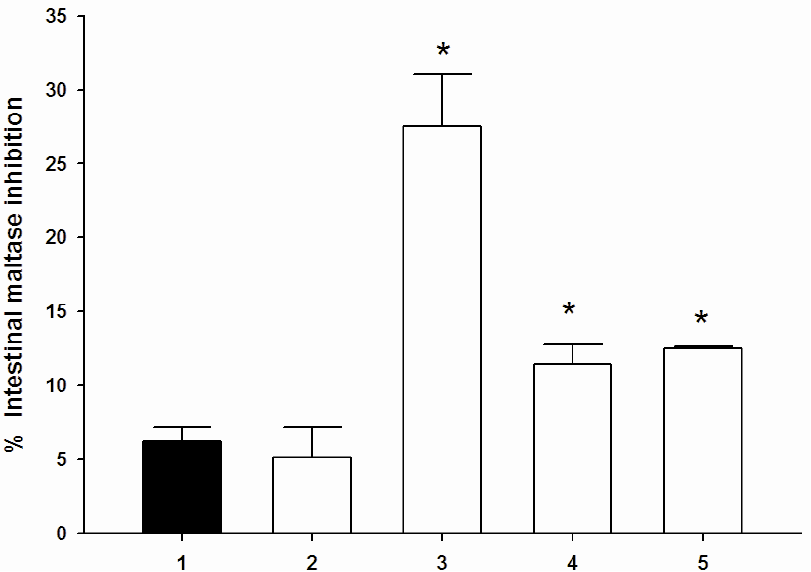
Figure 2. The combined effect of acabose and cyanidins on intestinal maltase inhibition.